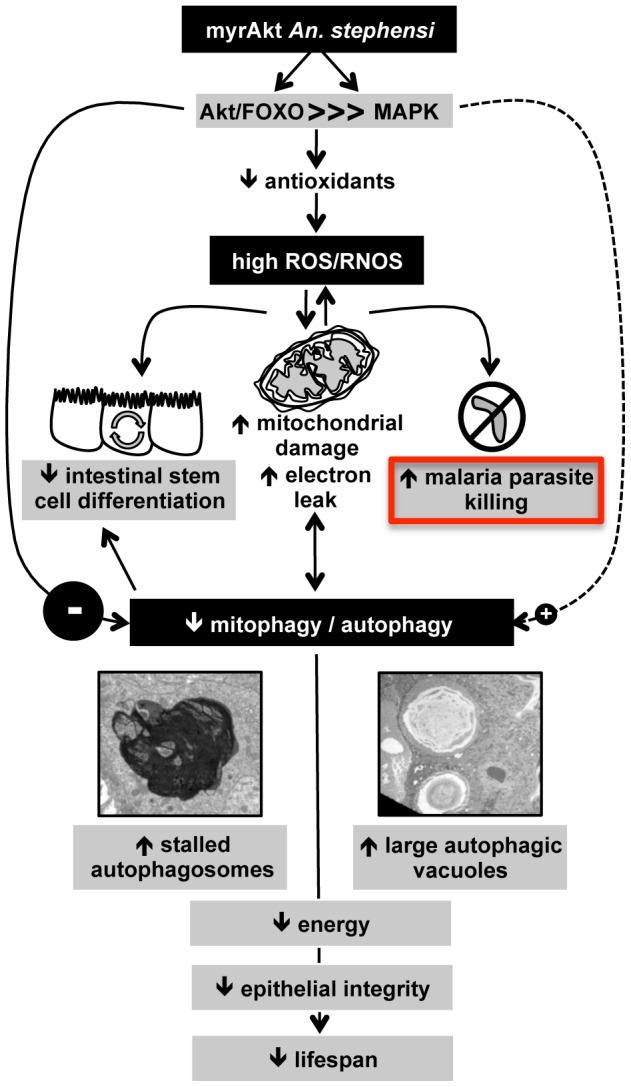
Over-expression of myrAkt in An. stephensi disrupts midgut mitochondrial dynamics, which impacts local and systemic physiology to drive anti-parasite resistance and reduced lifespan.The overexpression of myrAkt in the An. stephensi midgut induces FOXO phosphorylation [5], which results in a reduction in both mitochondrial and cytoplasmic antioxidants. This reduction leads to increased levels of ROS and RNOS, which lead to mitochondrial damage and a feedback cycle that enhances RNOS to levels that are necessary and sufficient for malaria parasite killing. Although oxidative damage is a strong activating signal for mitophagy, strong repressive signals from myrAkt overexpression and MAPK down-regulation prevent successful resolution of mitophagy, as evidenced by the accumulation of stalled autophagosomes. The incomplete resolution of mitophagy sustains oxidative stress, which results in local and systemic energy deficits, incomplete mitochondrial biogenesis, and epithelial damage that is unmitigated by autophagy-dependent stem cell differentiation. The balance between positive and negative signals for autophagy underlies autophagic regulation in and coordination of cellular homeostasis, epithelial barrier integrity, lifespan, and immunity [17]–[21]. As in other organisms, mitochondrial dysfunction, via Akt-dependent RNOS-mediated stress and dysregulated autophagy, perturbs midgut homeostasis or “midgut health” to enhance anti-parasite resistance and reduce the duration of mosquito infectivity.